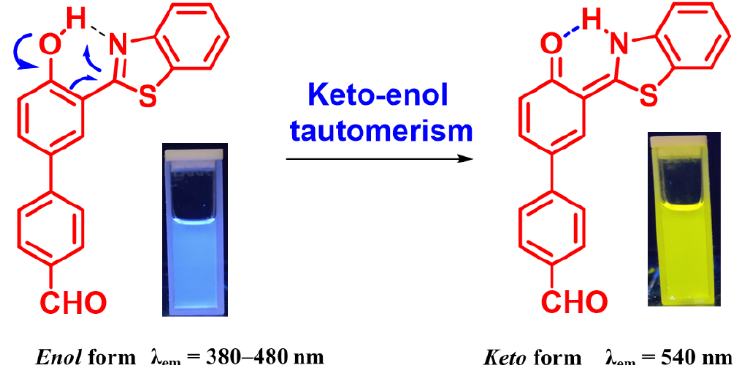
Figure 2. The general mechanism for keto – enol tautomerism in HBT 2 .